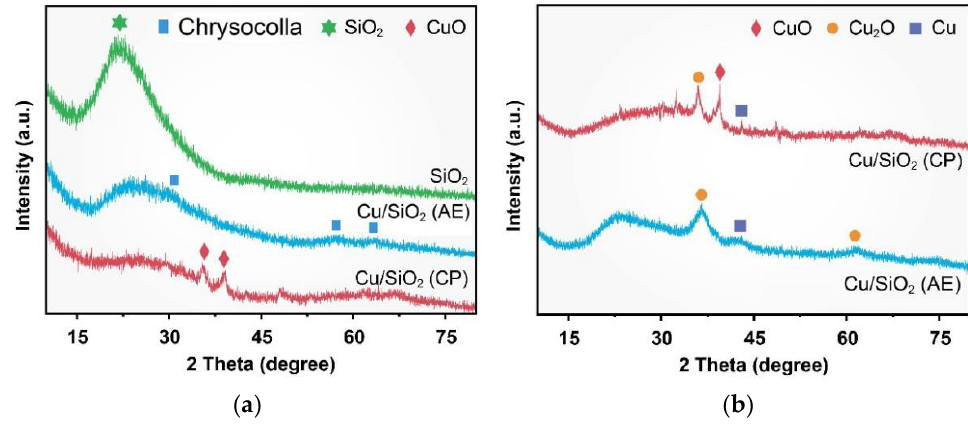
Figure 3. XRD patterns of Cu/SiO 2 (CP) and Cu/SiO 2 (AE) catalysts ( a ) calcined catalysts; ( b ) reduced catalysts.